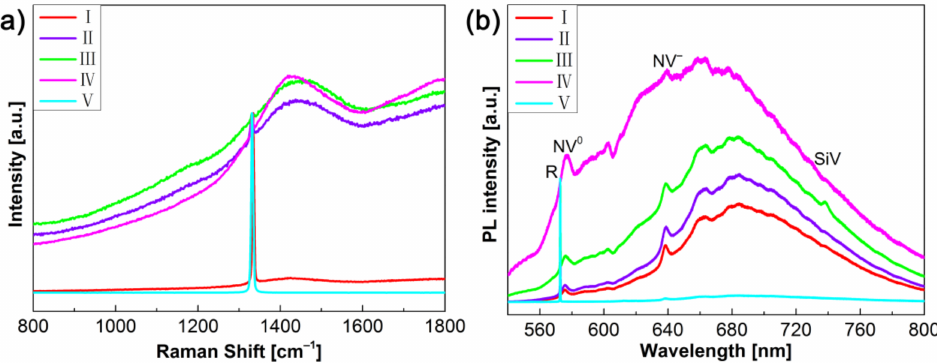
Figure 3. ( a ) Raman and ( b ) PL spectra of cross-section SCD layer/hillock interlayer/HPHT diamond structure. The Roman numerals of I, II, III, IV and V correspond to the positions for taking the Raman and PL spectra as indicated in Figure